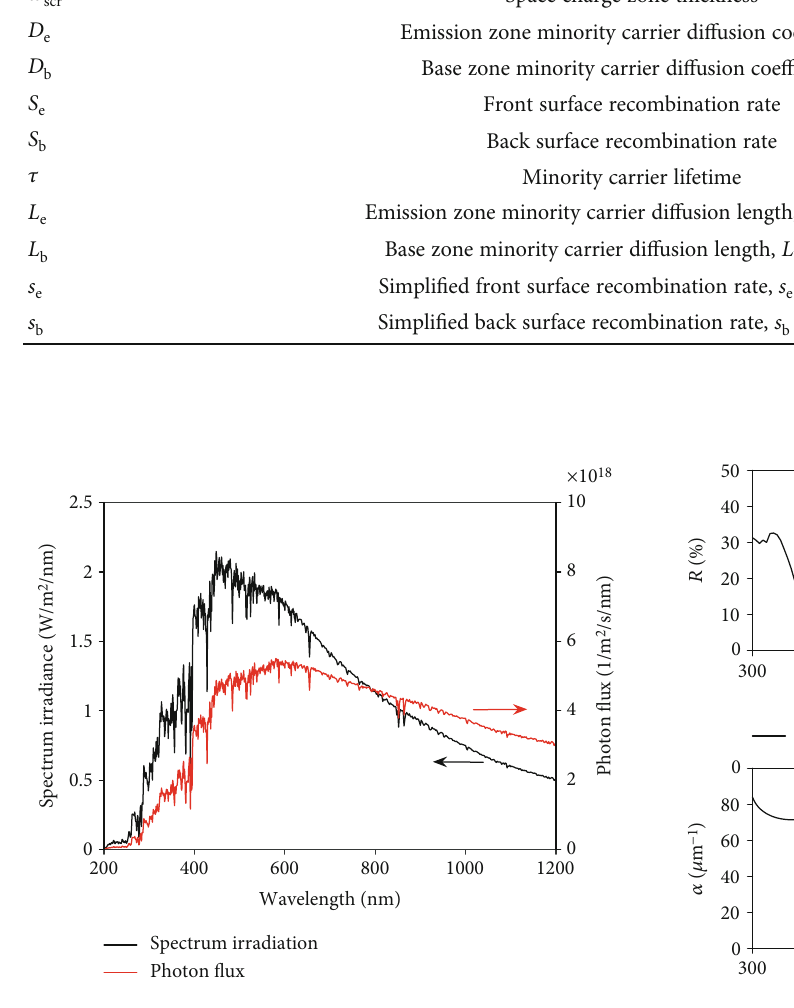
Figure 4: The AM0 solar spectrum irradiance and corresponding photon fl ux.